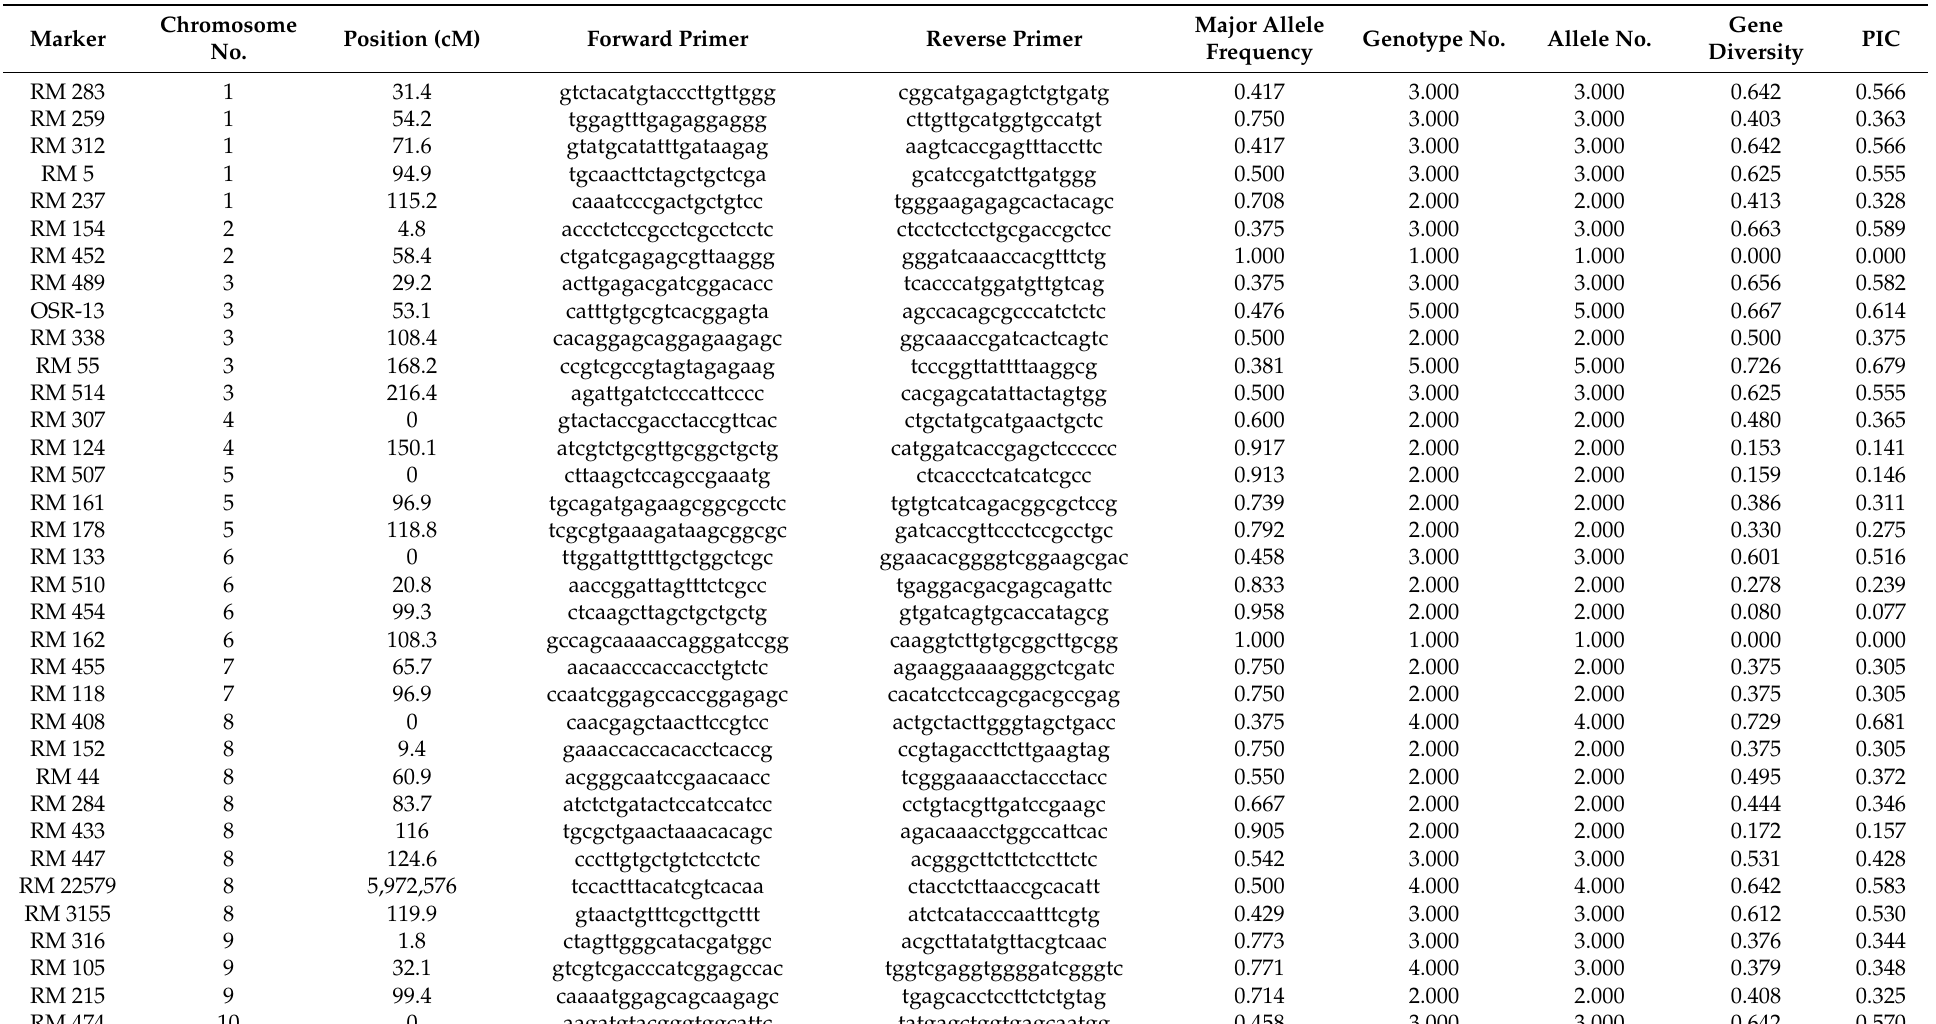
Table 7. Informativeness and profiles of the 46 SSR markers taken for the present